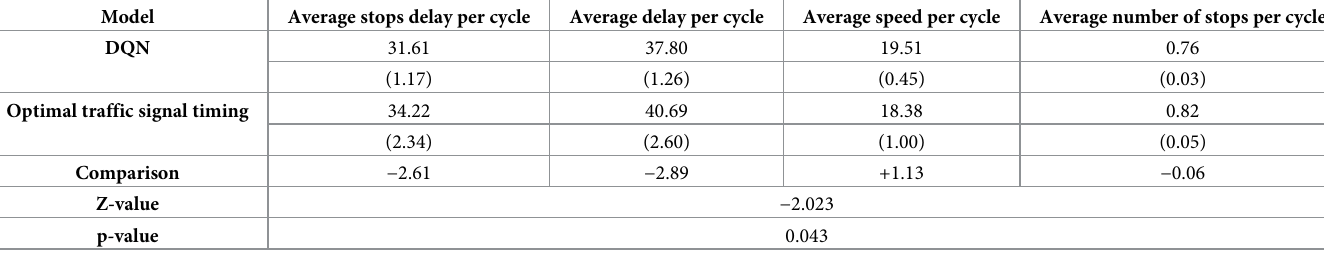
Table 5. Evaluation and validation results of scenario 2–1 in coordinated intersections.